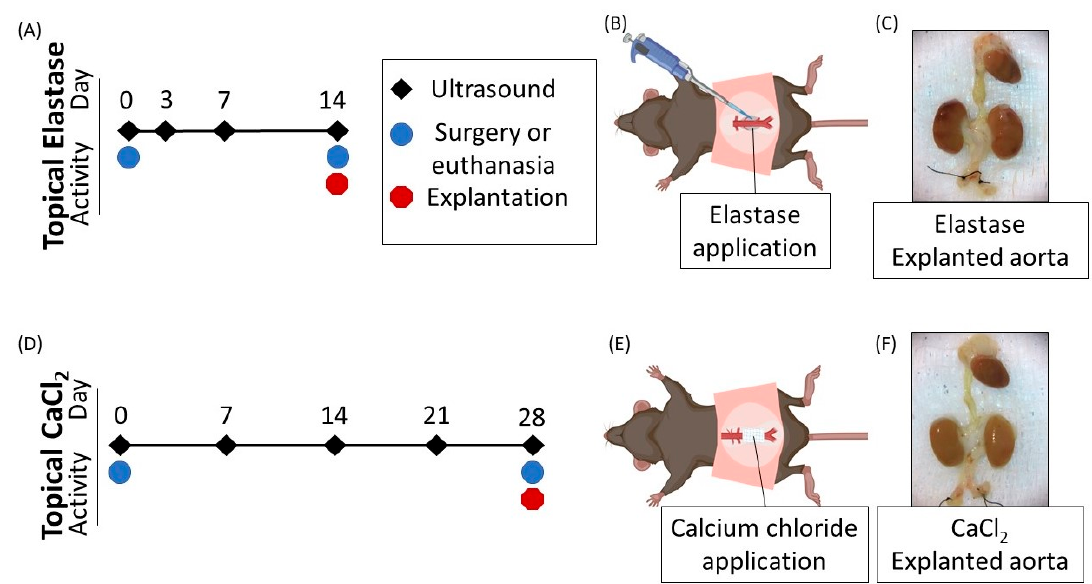
Figure 1. Timeline of experimental events. ( A ) Timeline for injuries induced by topical elastase. ( B ) Porcine pancreatic elastase was topically applied by pipette to the infrarenal aorta. ( C ) A representative aorta from the topical elastase group. Aortas were mechanically tested following explantation. ( D ) Timeline for injuries induced by calcium chloride (CaCl 2 ). ( E ) CaCl 2 was applied via gauze soaked in 200 µL of 0.5 M CaCl 2 . ( F ) A representative aorta from the topical CaCl 2 group. Aortas were mechanically tested following explantation.